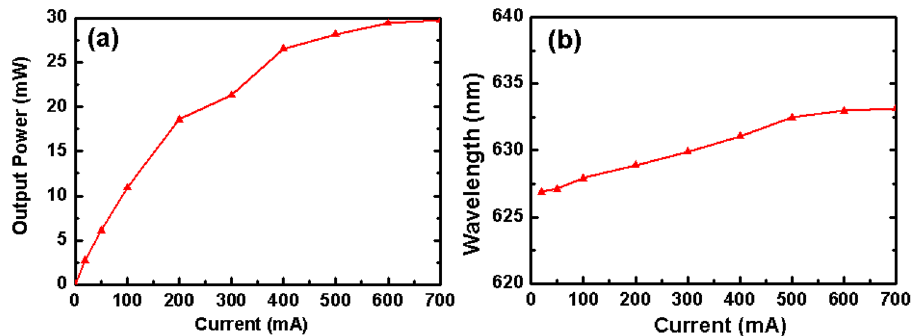
Figure 5. ( a ) Output power; ( b ) wavelength as a function of current for the LED/CIC chips after dicing.